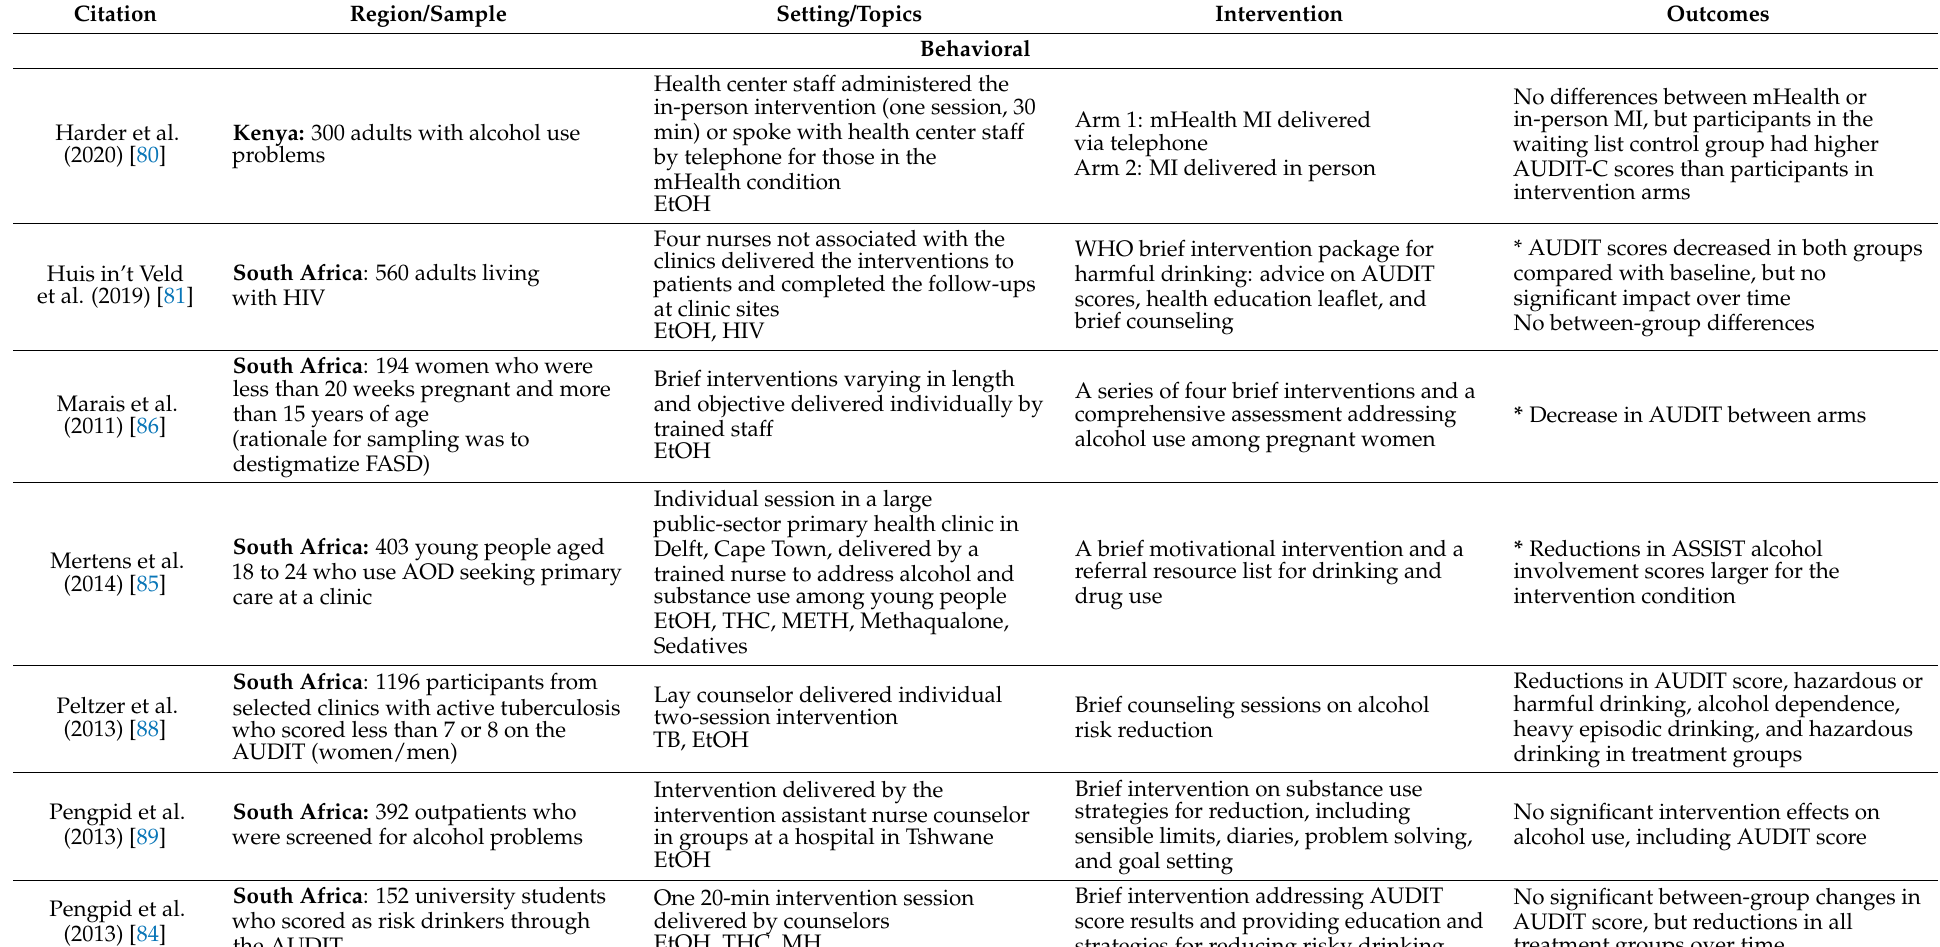
Table 2. Single-session or screening brief intervention and referral to treatment (SBIRTs) targeting individuals who use alcohol and other